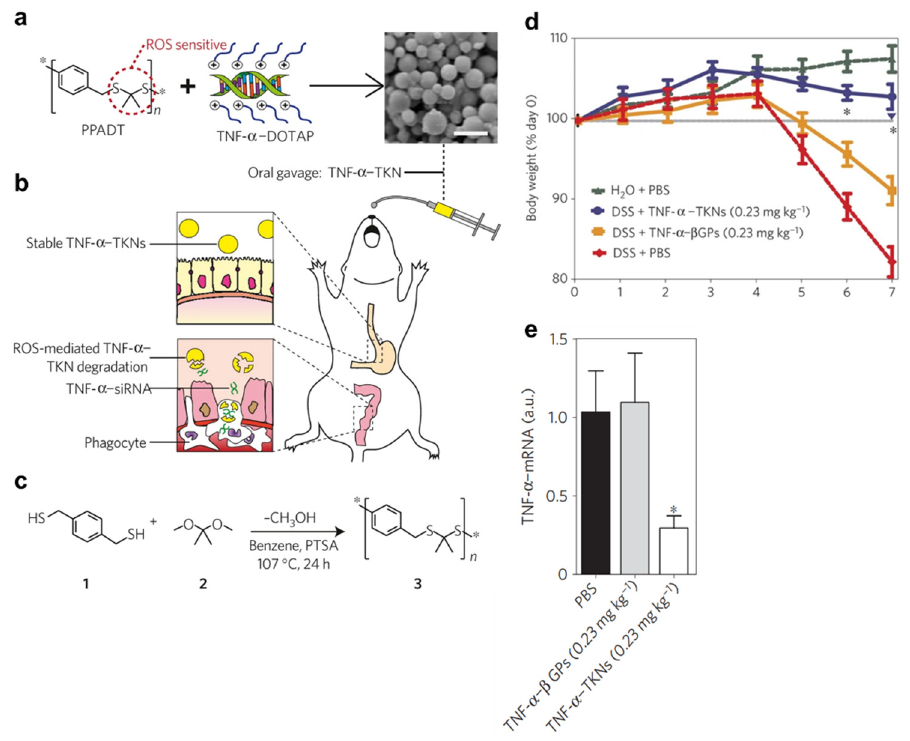
Figure 7. Polyplex nanoparticles embedded in ROS-responsive materials. ( a ): Poly-(1,4- pheyleneacetone dimethylene thioketal)(PPADT 3) is a new polymer composed of ROS-sensitive thioketal linkages (circled in red). The scanning electron micrograph shows TNF- α -loaded thioketal nanoparticles (TNF- α –TKNs) (scale bar represents 1.5 µm). ( b ): TNF- α –TKNs remain stable in the harsh environment of the gastrointestinal tract, while they degrade at the inflamed site where infiltrating phagocytes produce unusually high levels of ROS. Thus, TNF- α –siRNA is released at the inflamed site. ( c ): PPADT 3 was synthesized using the acetal exchange reaction. ( d ): Time course of mouse body weight. ( e ): Expression level of TNF- α mRNA decreased in the TNF- α –TKN treatment group. Statistical p -values: * p < 0.05. Reproduced with permission [108]. 2010, Springer Nature.